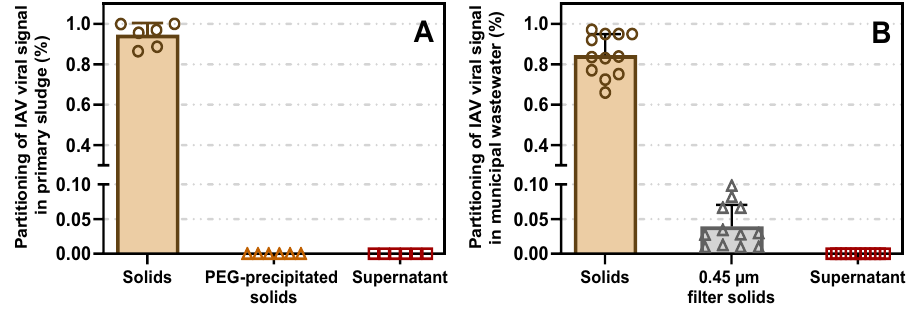
Figure 1. Partitioning of measured endogenous IAV viral signal present in: ( A ) primary sludge (n = 6); ( B ) municipal wastewater (n = 12). Means and standard error are displayed. Where the standard deviation is too small, the error bars are not displayed. Each measurement is based on three technical triplicates for each biological replicate.